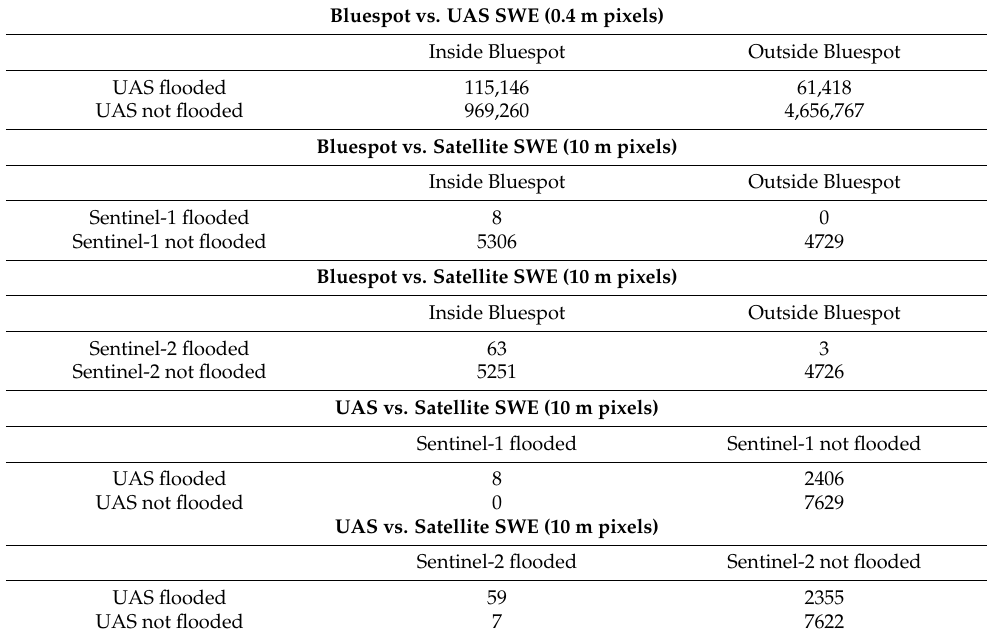
Table 2. Contingency table for the Øland